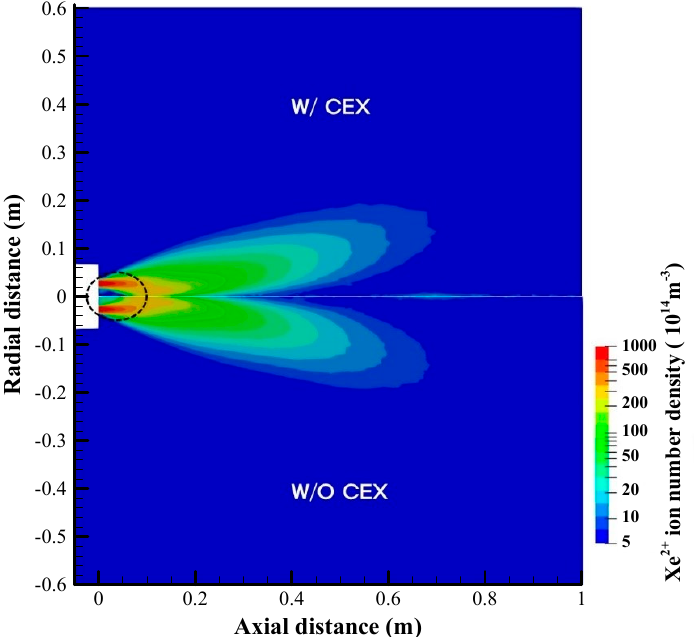
Figure 11. Contours of the Xe 2+ ion number density (top: with CEX effects, bottom: without CEX effects).